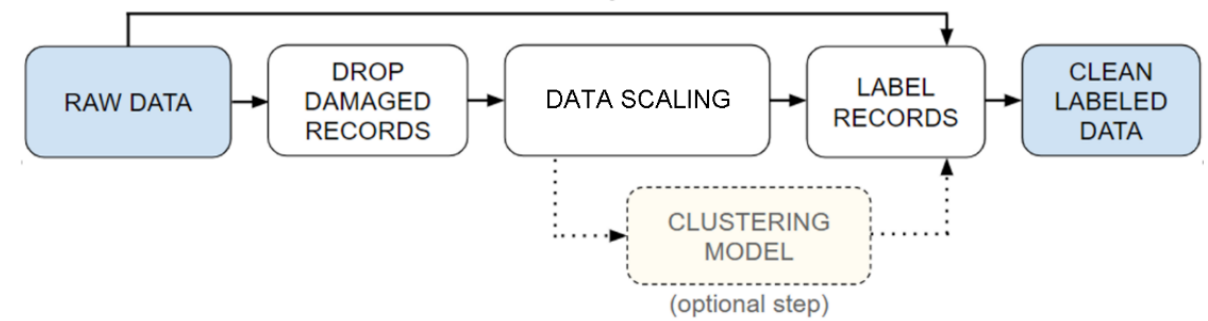
Figure 3. Block diagram representing data pre-processing pipeline.